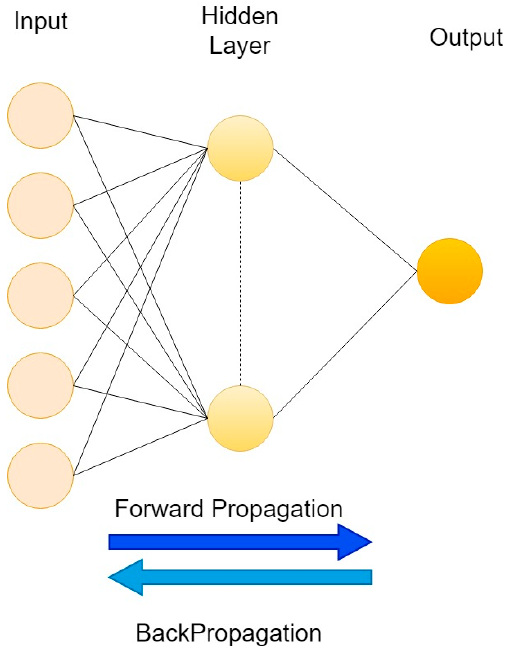
Figure 1. Typical structure of backpropagation algorithm - artificial neural network (BP-ANN) algorithm.